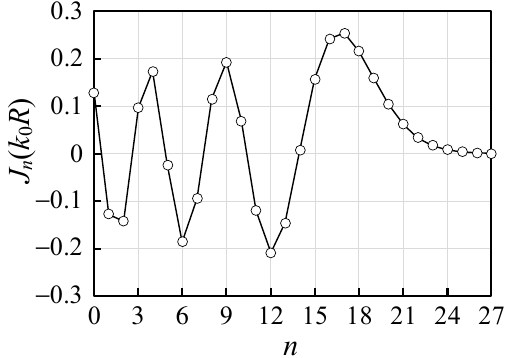
Figure 2. Variation of Bessel functions ( R = 3 λ , λ = 3 cm).